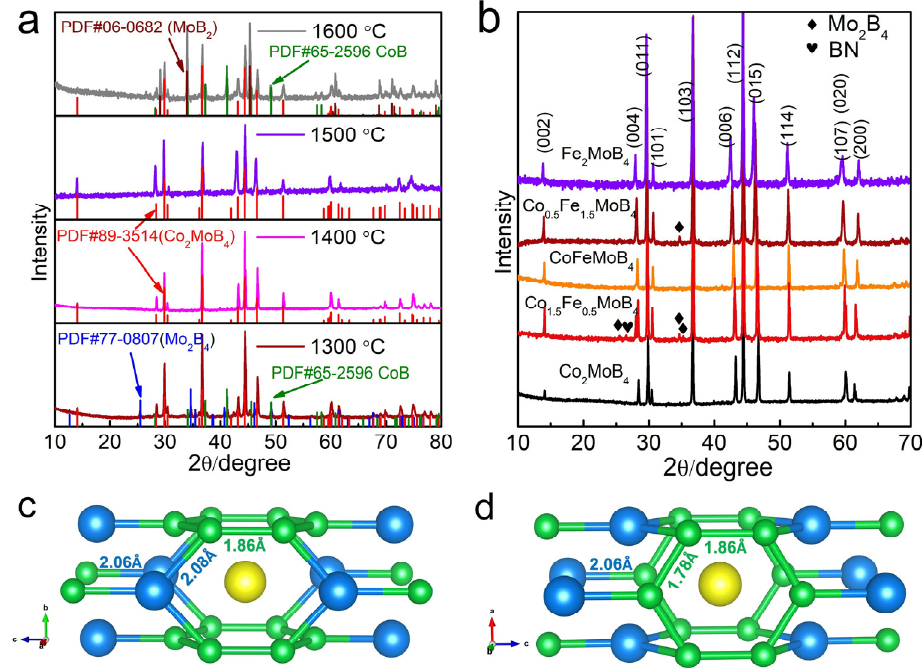
Figure 1. ( a ) XRD patterns of Co 2 MoB 4 synthesized at 1300 ◦ C, 1400 ◦ C, 1500 ◦ C, 1600 ◦ C; ( b ) XRD patterns of Co 2 MoB 4 , Fe 2 MoB 4 and Co, Fe co-doped samples; ( c , d ) are a scheme of crystal structure of Co 2 MoB 4 (yellow spheres are Mo atoms, green spheres are B atoms, blue spheres are Co